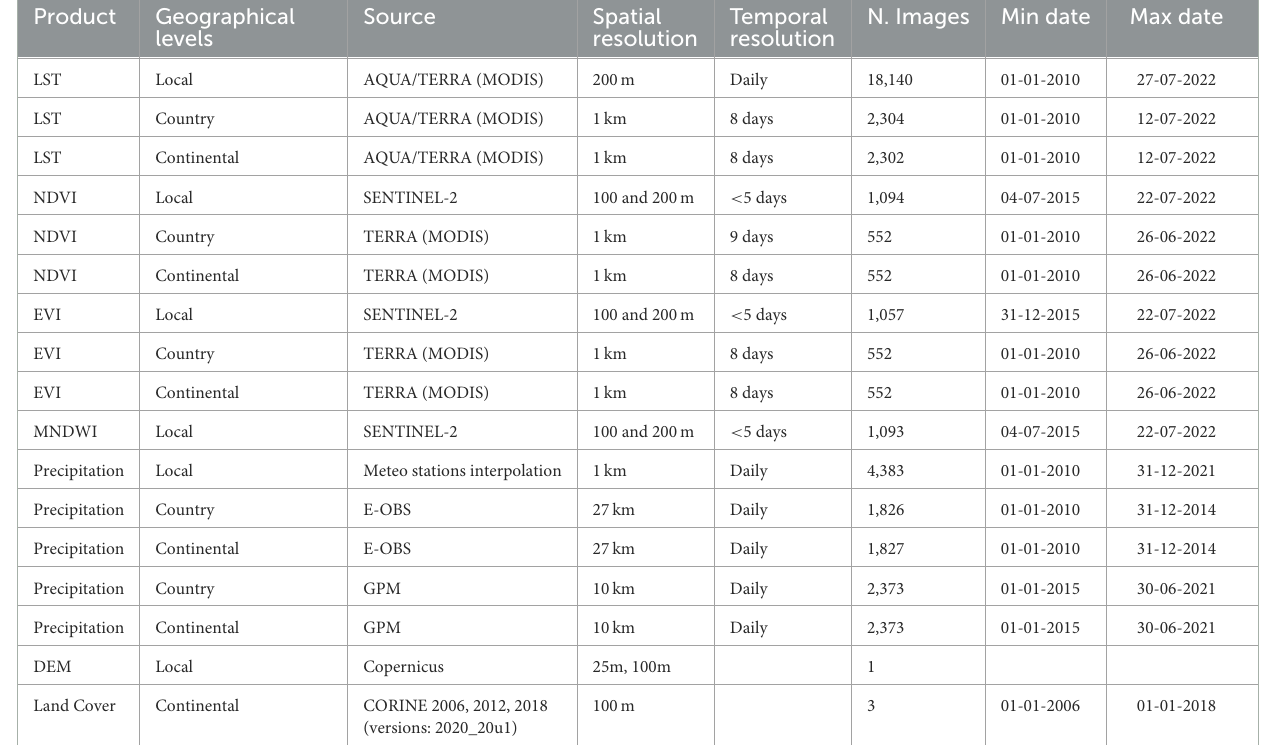
TABLE 1 Summary of the EVE dataset as of August